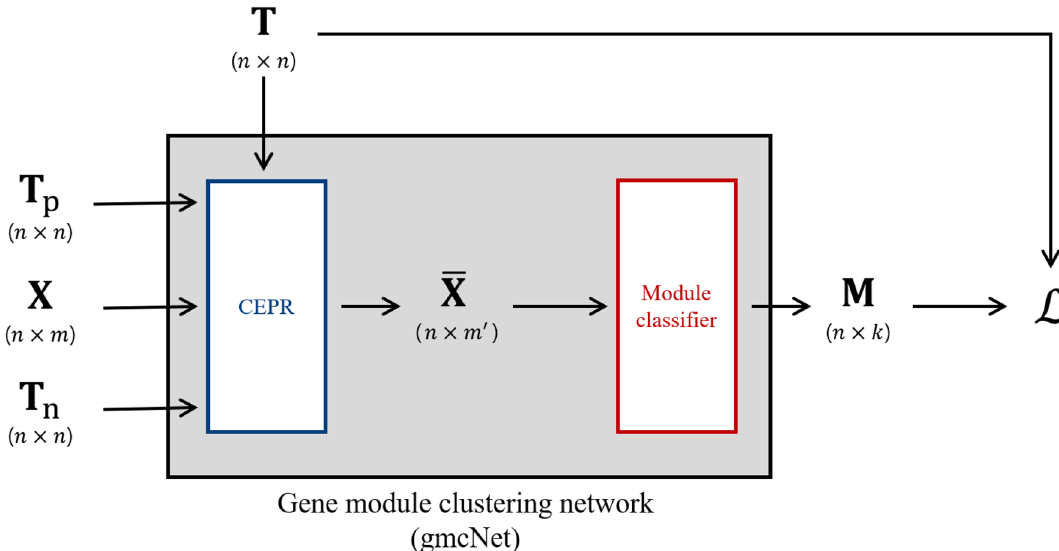
R n m is the single-level expression of n genes in m samples. × ∈ R n M k is assignment probability matrix of n ′ dimension. × ∈